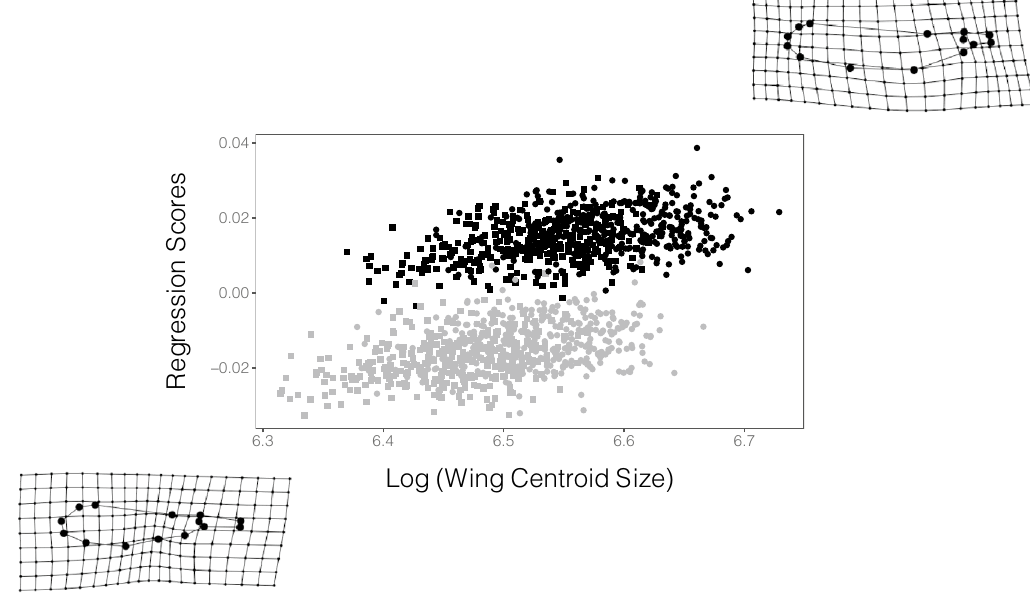
Figure 5. Allometric variation of wing shape of Lestes sponsa . Wing centroid size was derived from landmark coordinates in pixels. Fore- and hindwings of males and females are coded differently (female forewings: black circles; female hindwings: black squares; male forewings: gray circles; male hindwings: gray squares), but note that the regression slopes did not differ between these groups. Deformation grids depicting the extremes of allometric wing shape variation are included. The grids are exaggerated × 10 times for ease of